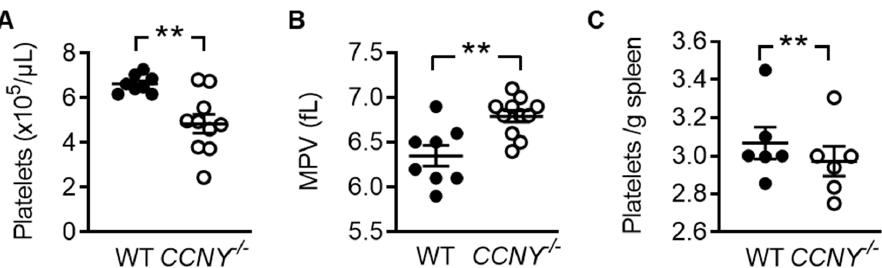
Figure 2. CCNY is important for platelet biogenesis. ( A ) Number of platelets in whole blood from wildtype (WT) vs CCNY - / - mice; ( B ) Mean platelet volume in wildtype (WT) vs CCNY - / - mice; ( C ) Number of platelets in the spleen from wildtype (WT) vs CCNY - / - mice. n = 6–10 (Student’s t test), ** p < 0.01.